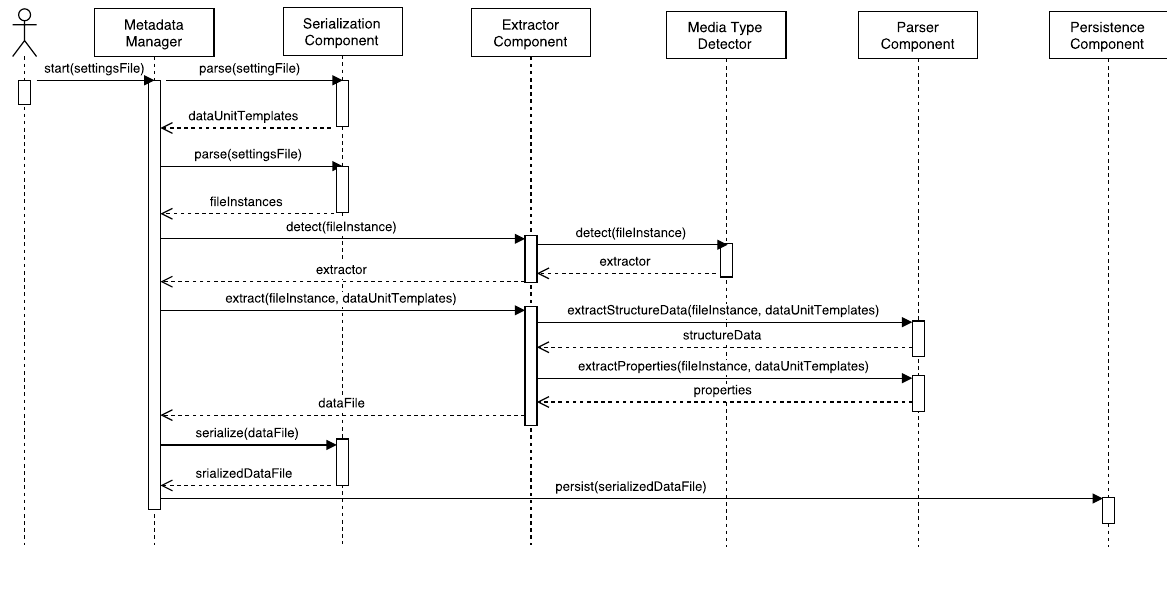
Figure 5. Behavioural